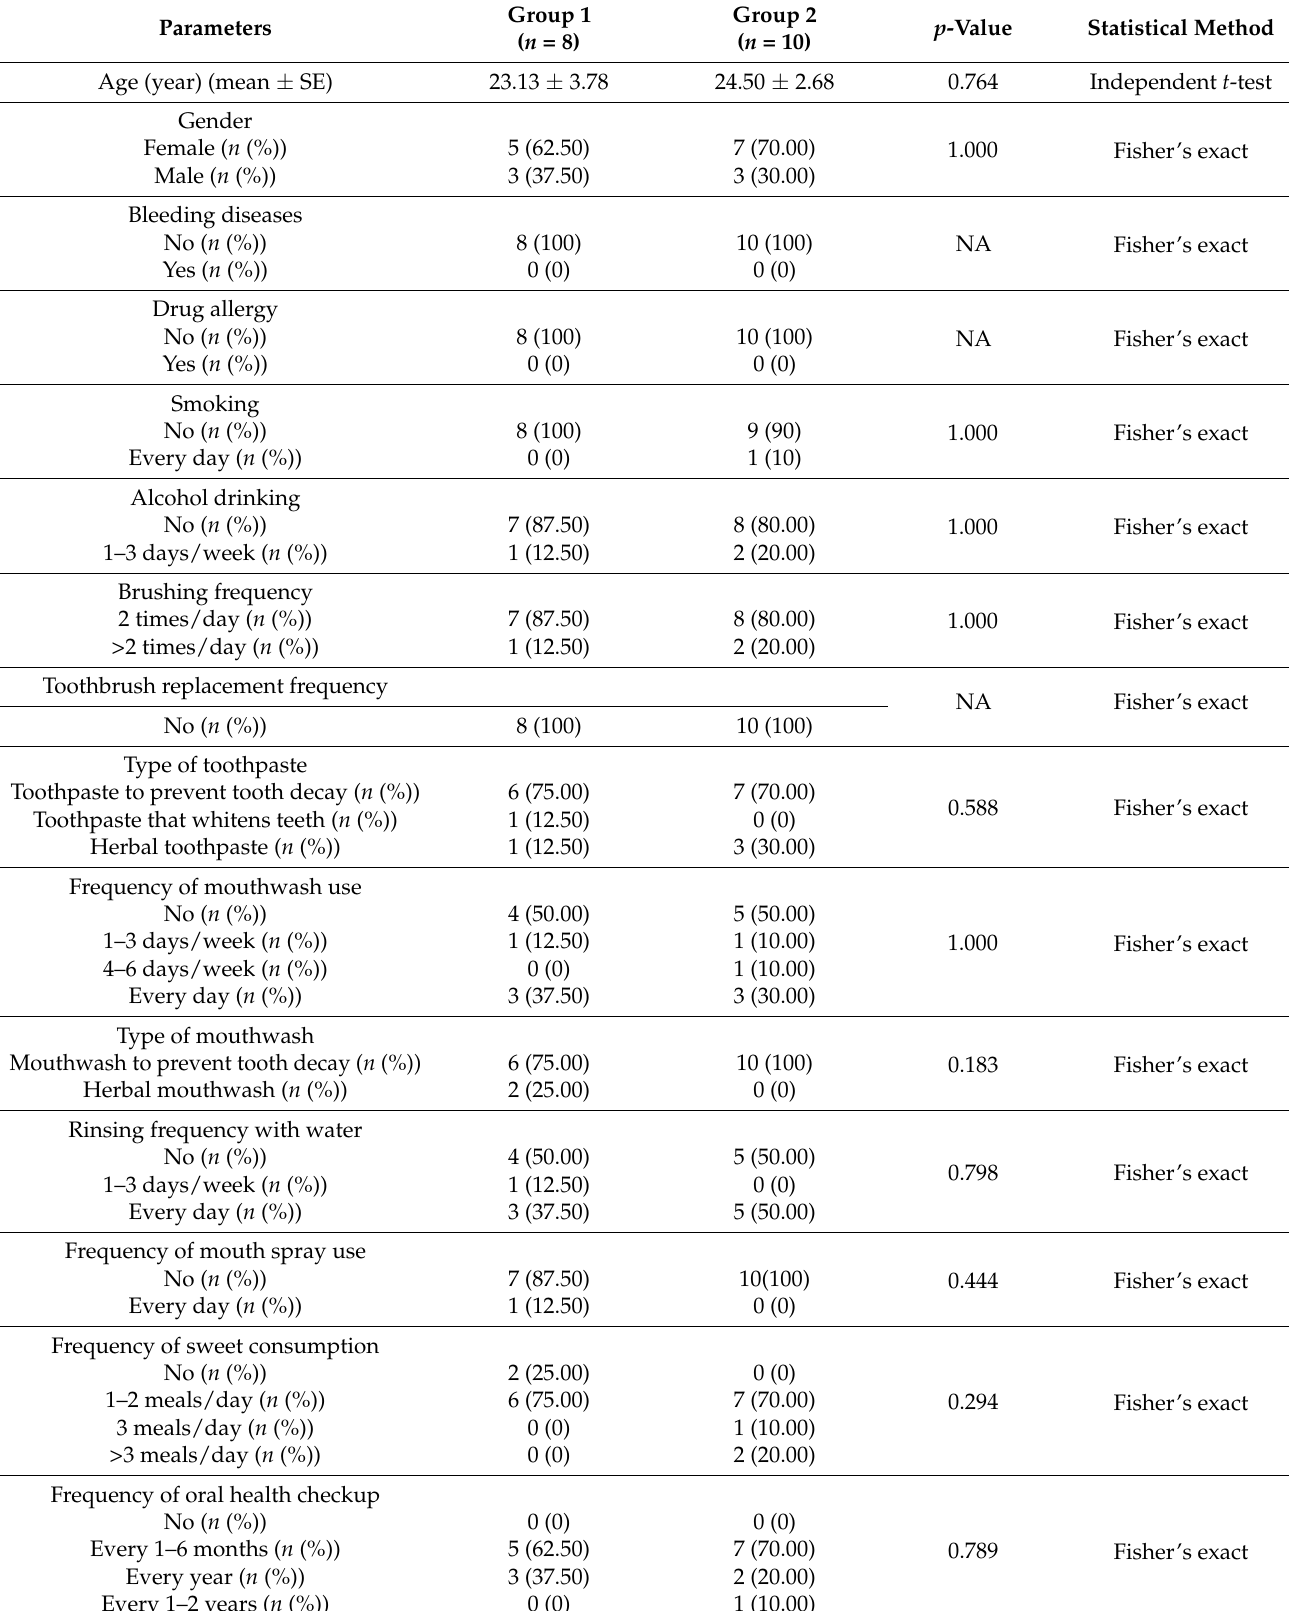
Table 1. The demographic data of the study